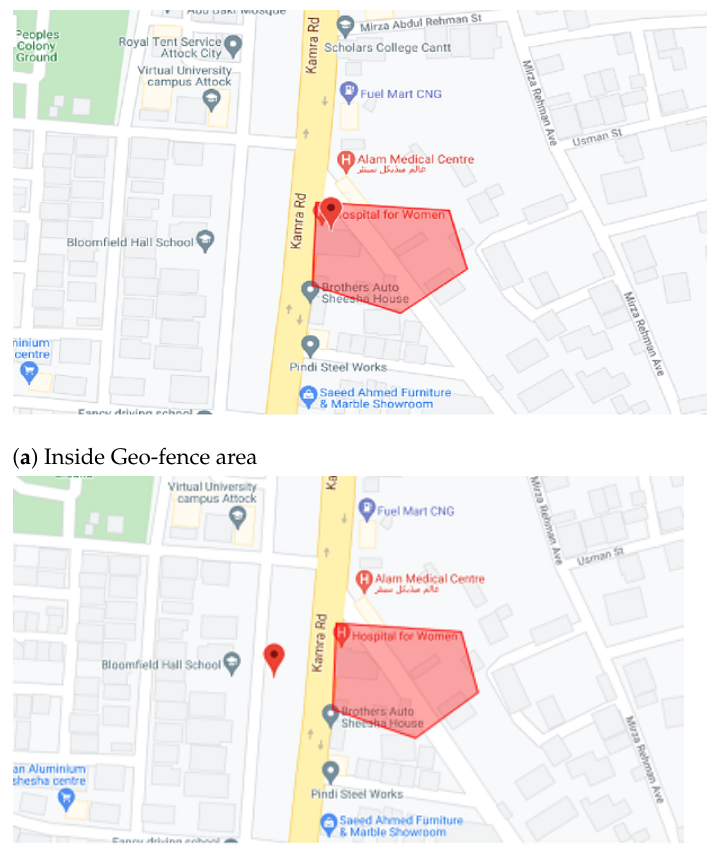
Figure 15. Geo-fencing of the COVID-19 susceptible and patients in Quarantine Management. ( a ) inside Geo-fence area; ( b ) outside Geo-fence area. The normal heart rate variation depends on whether one is male to female. Beats per minute (BPM) for males is 72 and for females is 78. However, due to the increase in respiration rate and fever, the heart rate increases. Figure 16 sub-figure 6 represents heart rate variation from 85 to 100 BPM of COVID patients. The SpO 2 level of